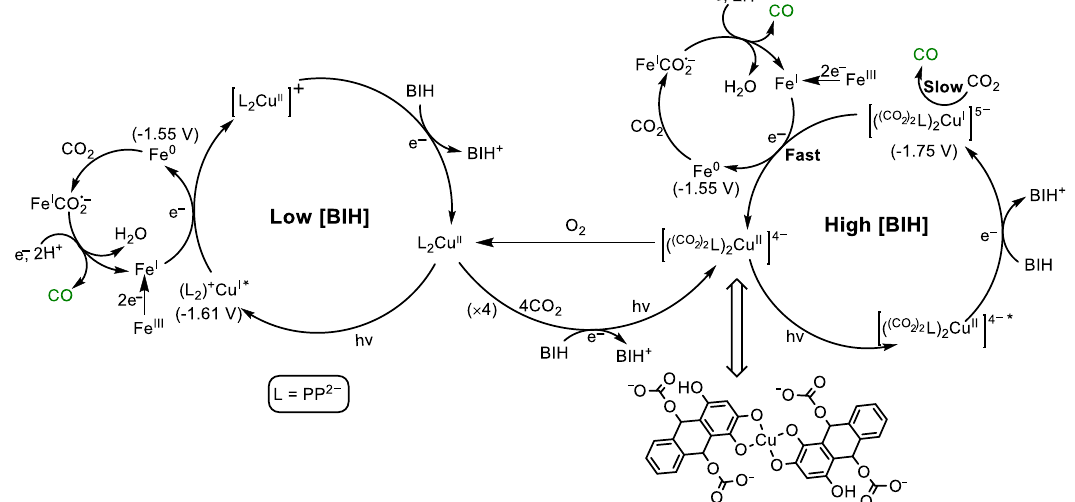
Fig. 8 Proposed reaction scheme. Different pathways for photocatalytic CO 2 reduction are proposed for low [BIH] (left) and high (BIH)